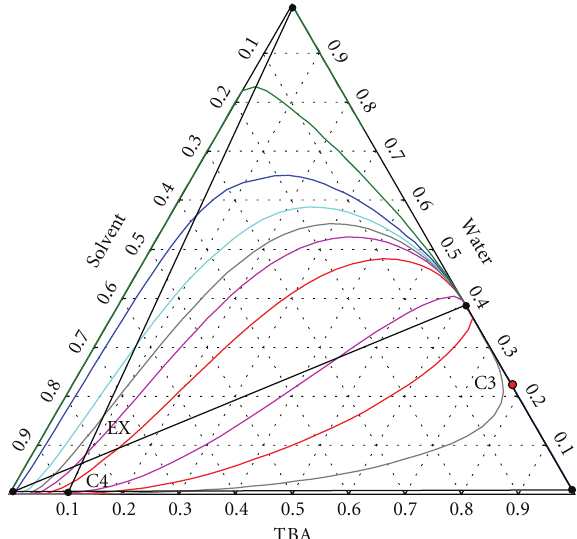
Figure 6: Residue curve map of the TBA-water-1,4-butanediol